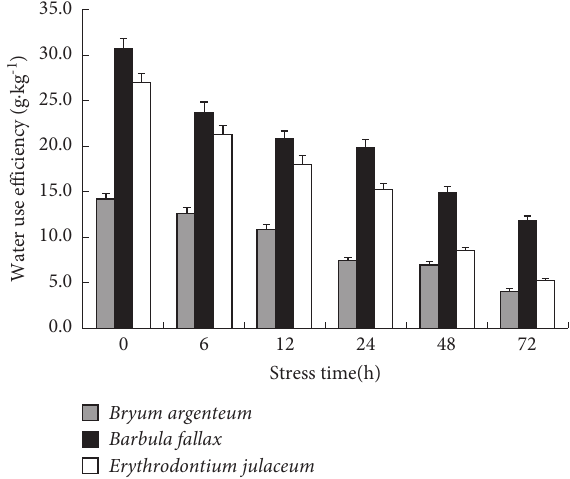
Figure 5: Effects of the drought stress on water use efficiency in three types of epiphytic